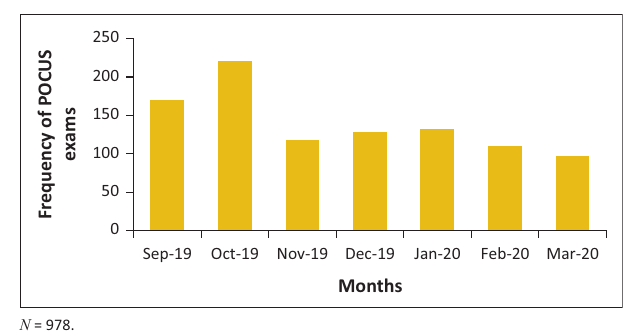
FIGURE 3: The types of point-of-care ultrasound exams performed and frequency of each